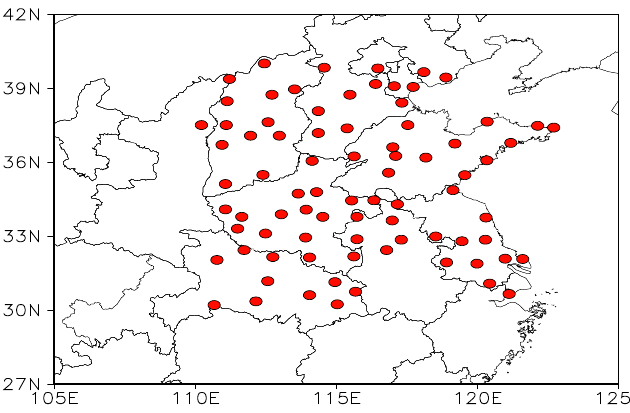
Figure 1. Locations of the selected stations.